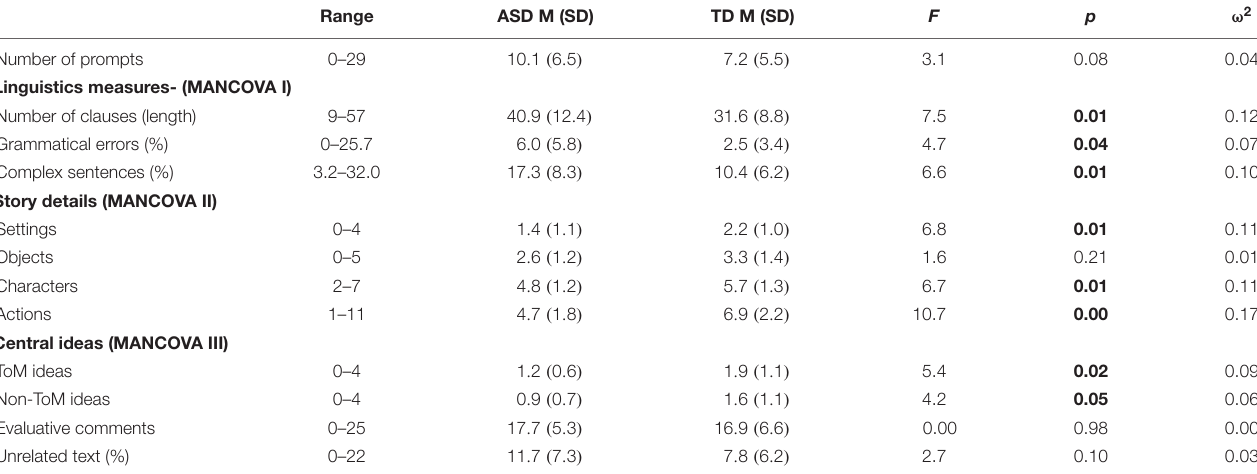
TABLE 2 | Analysis of narrative